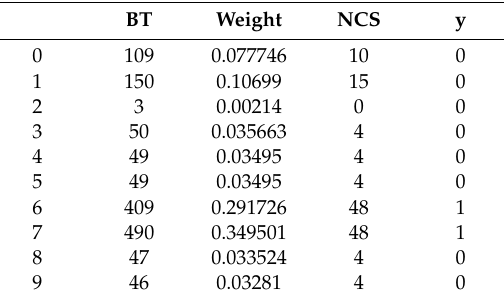
Table 4. Clustered dataset_1.